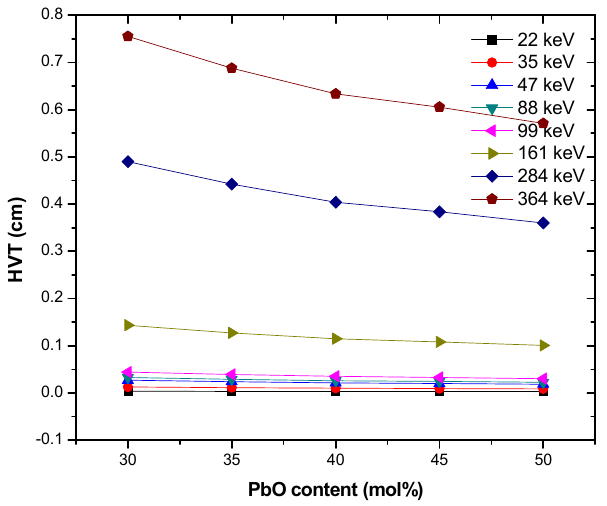
Figure 5. HVT of the investigated glasses at different energies and PbO molar concentration.